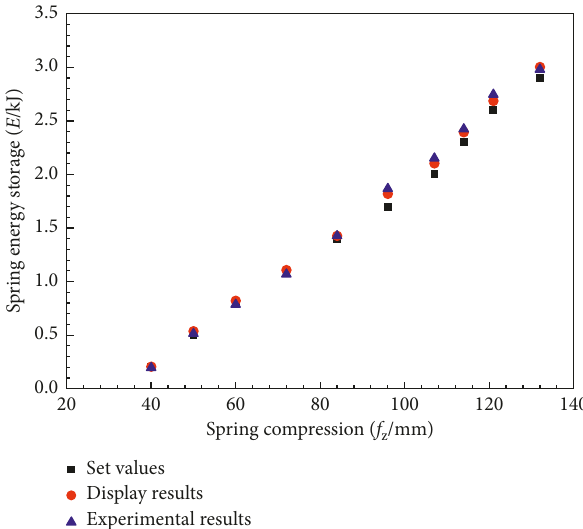
Figure 13: Comparison among the set, display, and experiment results.